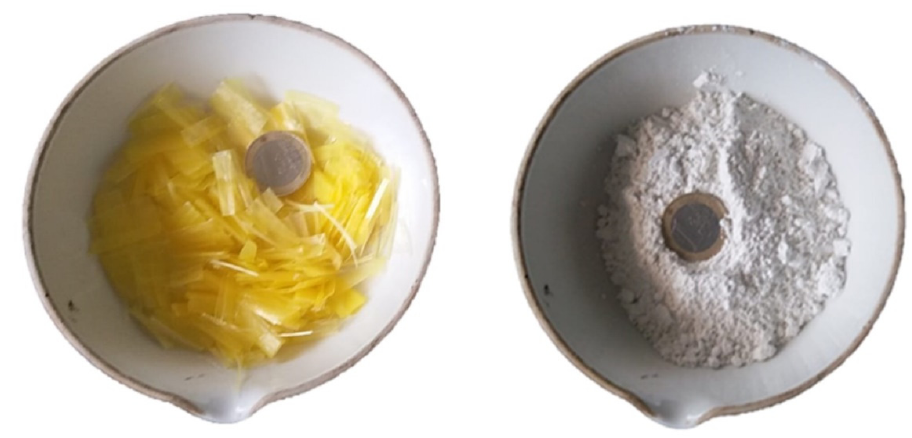
Figure 1. Modifiers used in this research. Pol-Aram fibers ( left ) and hydrated lime ( right ).